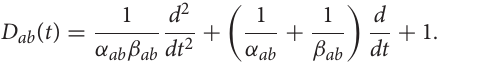
Frontiers in Human Neuroscience |